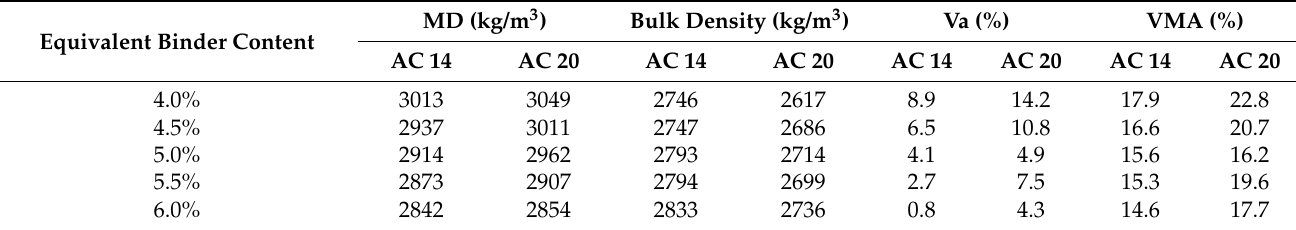
Table 8. Volumetric characteristics of mixtures with 75% SSA for different binder